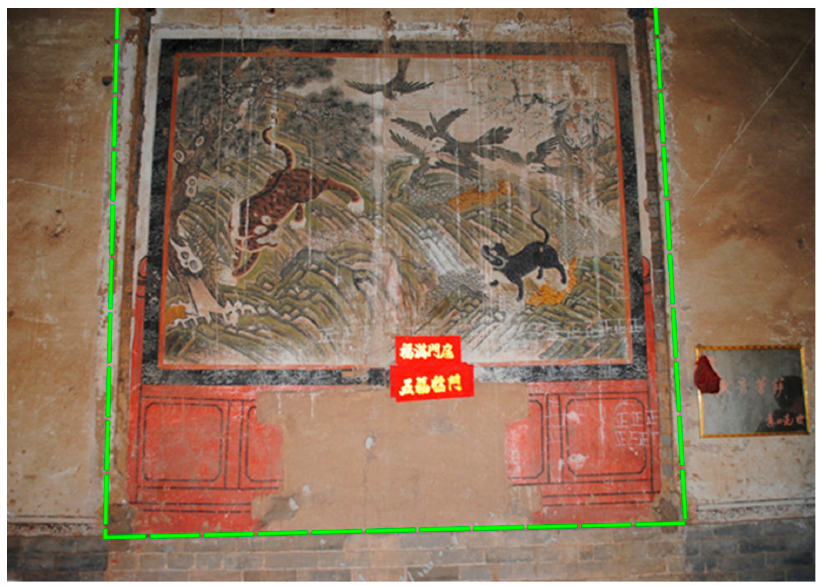
Figure 5. A single ‐ panel seated screen in the Guandi Temple in Hedong Village, Mishan Town (No. 84 in Figure 1).